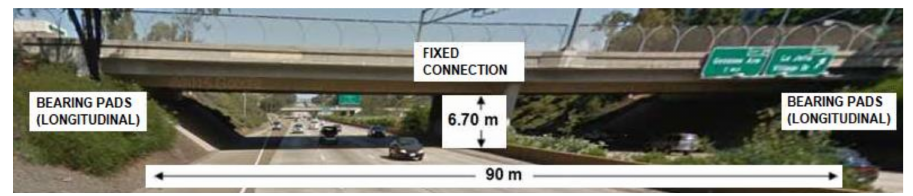
Figure 4. Case study.